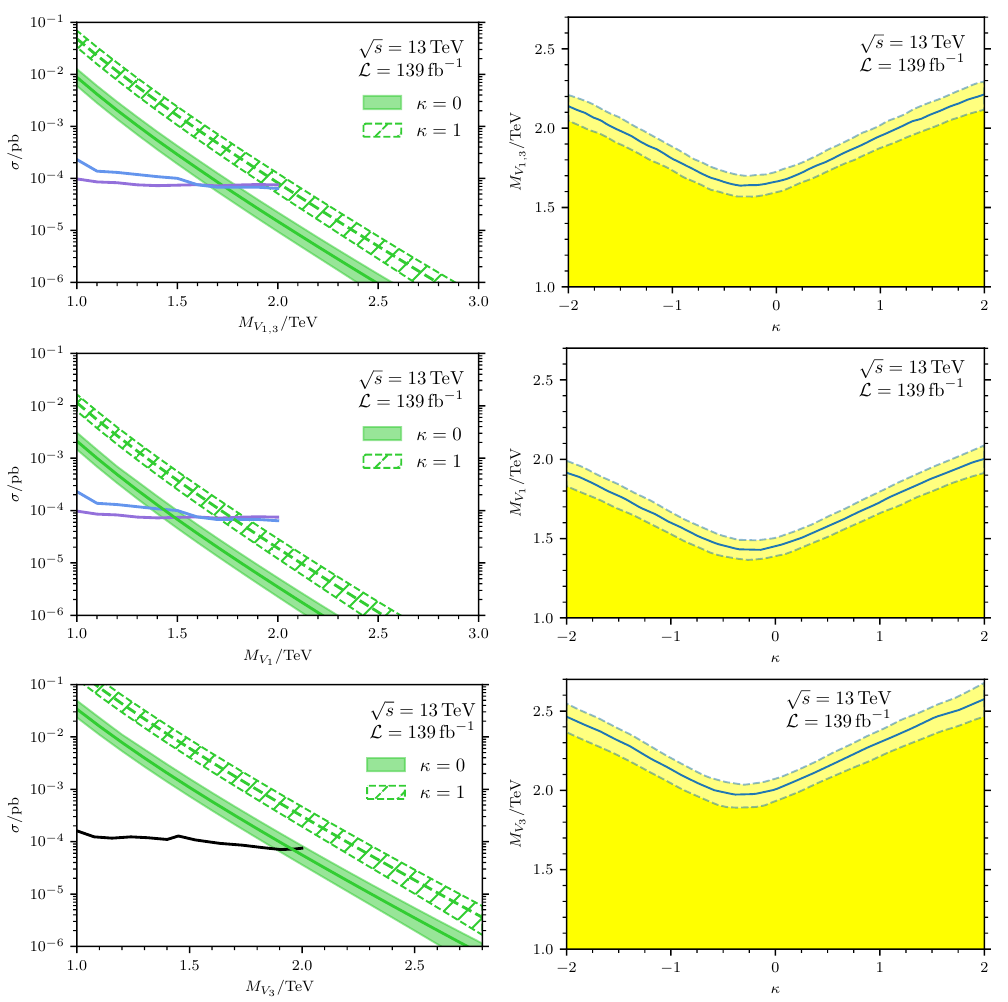
Figure 3 . Sensitivity and mass bounds from reinterpretation of a current ATLAS search [22]. Top row: V 1 in the hierarchical and flipped flavor scenarios, which equals V 3 in the hierarchical and democratic flavor scenarios, middle row: V 1 in the democratic scenario, and bottom row: V 3 in the flipped scenario. Left: sensitivity to V 1 , V 3 -pair production, assuming dominant decays to µb , µq and µc in purple, blue and black, respectively; q denotes quarks lighter than the charm quark, The green bands indicate the theory prediction including the pdf- and scale uncertainties, for κ = 0 (solid) and κ = 1 (dashed). Right: mass bounds for the leptoquarks V 1 , V 3 as the function of parameter κ (2.6). The boundary of the excluded region is represented by the band whose width results from the pdf- and scale